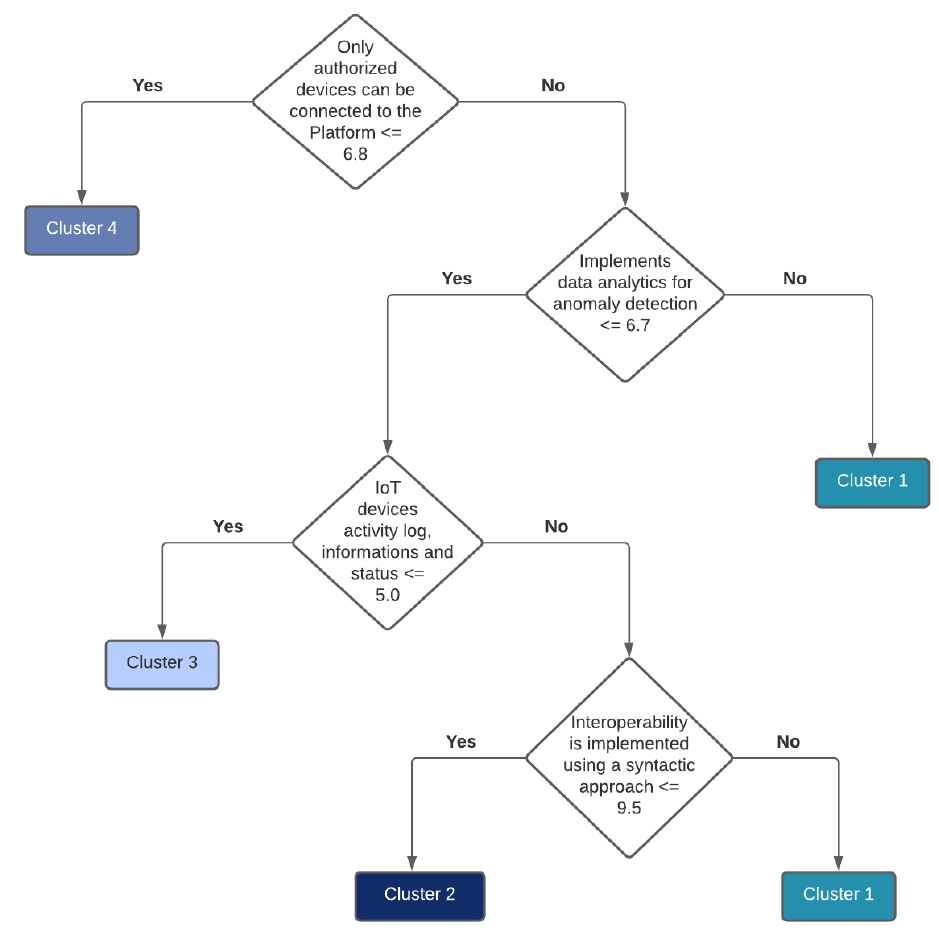
Figure 6. Taxonomy for four clusters from Figure